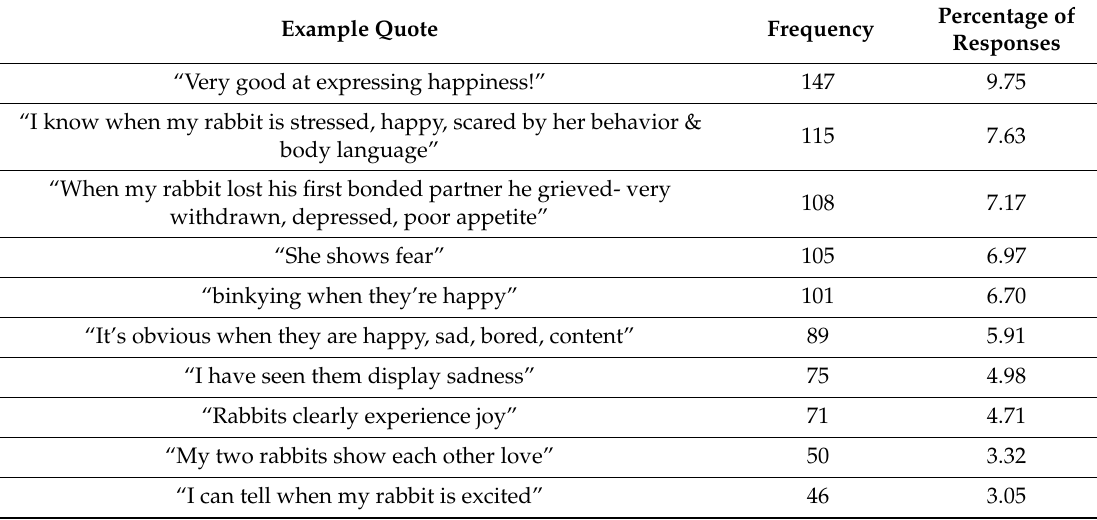
Table 7. Open-ended responses referring to rabbit emotion. Statements included in the table if they were mentioned in over 3% of responses. n =